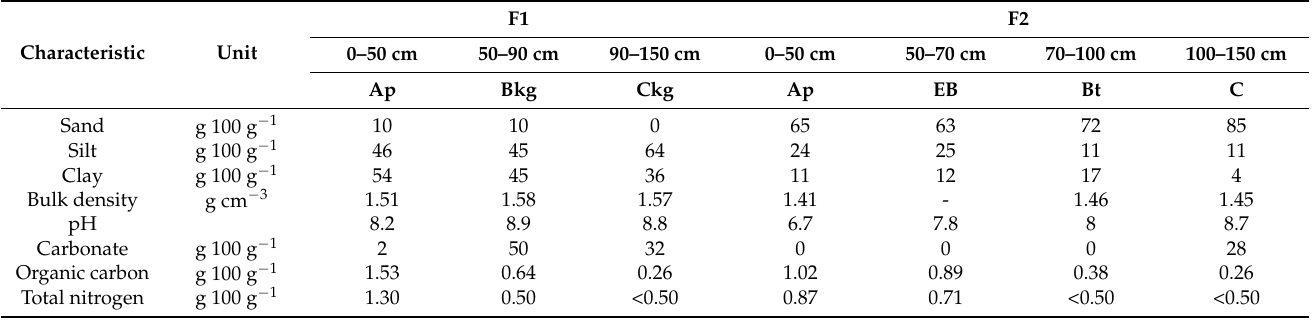
Table 1. Soil profile characteristics at Farm 1 and